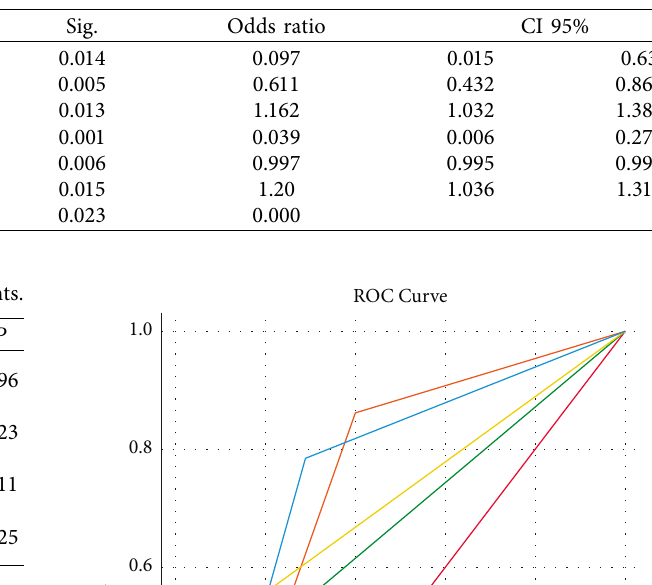
Table 4: Logistic regression for predicting discharge from hospital.